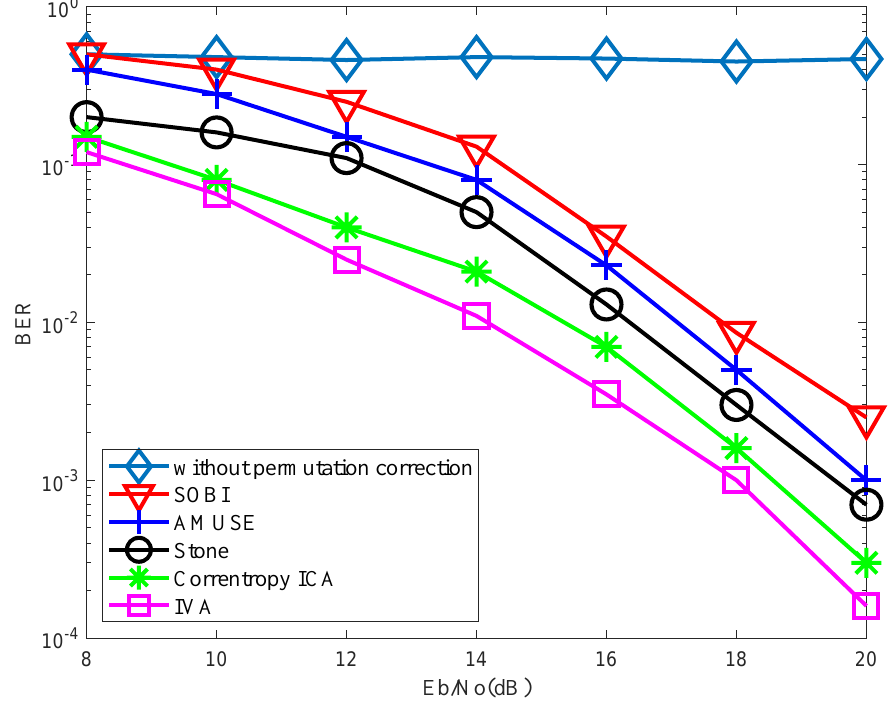
Figure 8. BER performance comparison for different